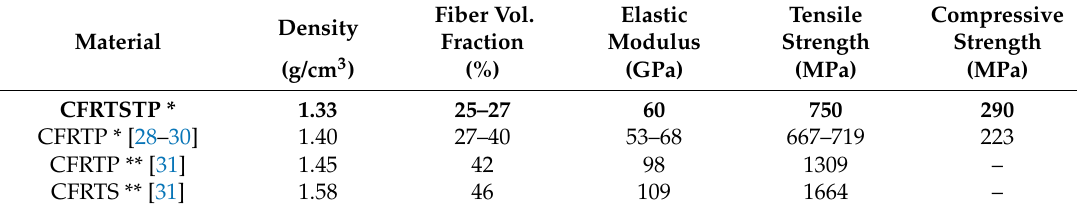
Table 1. Mechanical properties of carbon